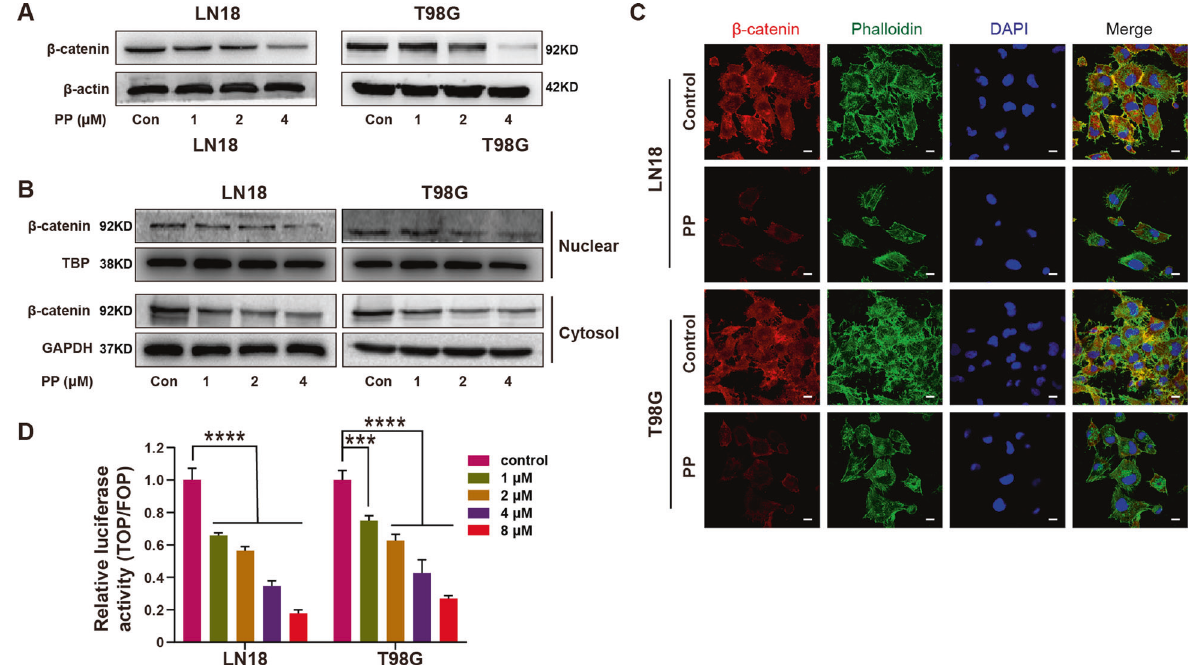
Fig. 4 PP inhibited the Wnt/ β -catenin signaling pathway within the GBM cells. A The PP role in β -catenin protein level was measured through western blotting. B Expression of β -catenin in the cytoplasm or nucleus was examined by western blotting following PP treatment at different contents. C β -catenin expression within LN18 and T98G cells following 2.0 μ M PP treatment examined by immuno fl uorescence. The scale bar is 20 µm. D TCF/LEF-dependent luciferase activity was measured following PP treatment for 24 h ( n = 3). The results were presented in the manner of mean ± SD. *** p < 0.005; **** p <